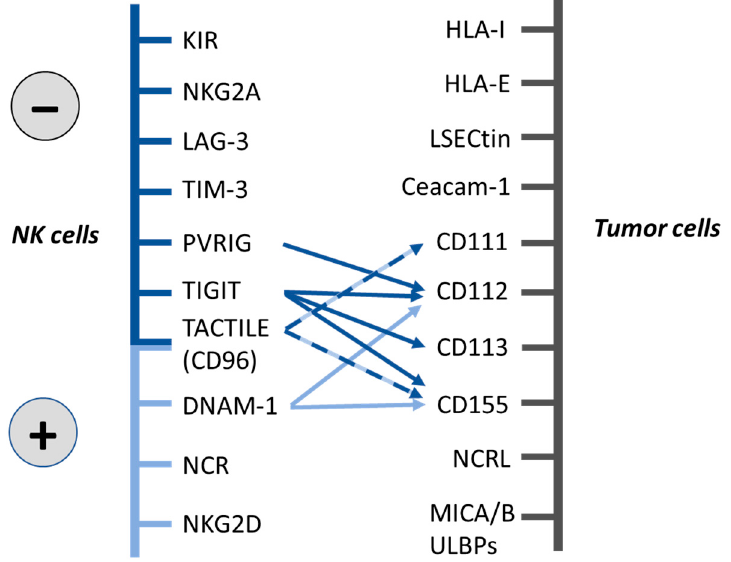
Figure 1. Natural killer (NK) cell activating and inhibitory receptors and their ligands on tumor cells. Inhibitory receptors are indicated in dark blue and activating receptors in light blue. While mouse TACTILE expresses only intracytoplasmic inhibitory motifs, human TACTILE expresses both inhibitory and activating motifs (indicated with dotted dark blue-light blue arrows).